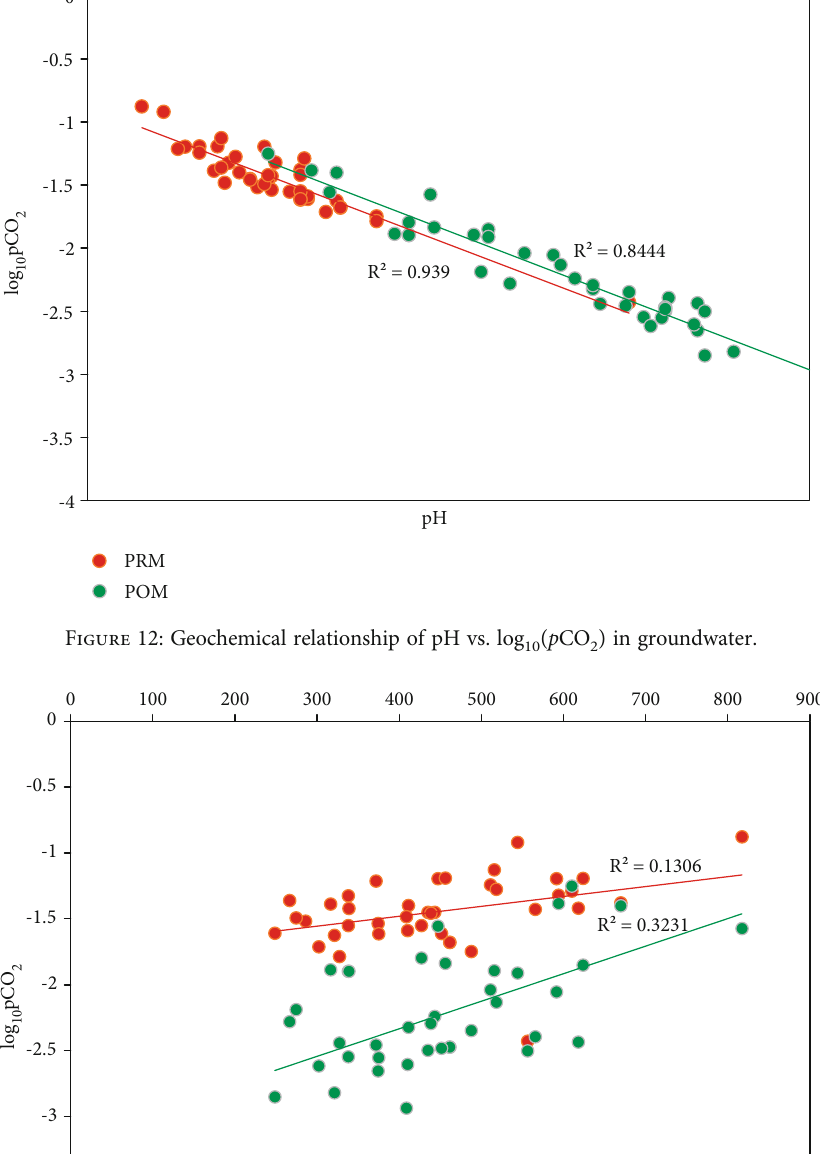
Figure 13: Geochemical relationship of [HCO 3- ] vs. log